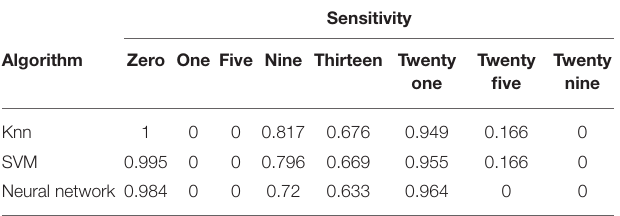
TABLE 4 | Sensitivity of different algorithms for 2D lattice